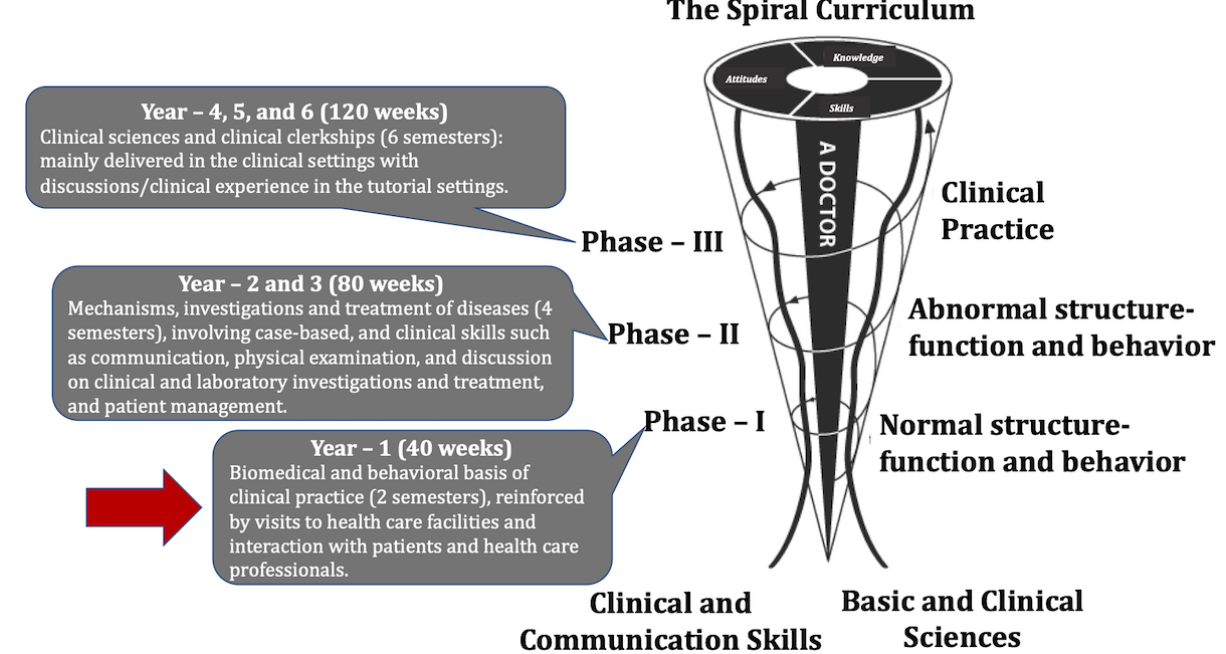
Figure 1. The undergraduate medical curriculum at Mohammed Bin Rashid University of Medicine and Health Sciences (MBRU). The curriculum is divided into three phases and spans over 6 years. Note: Each phase of the undergraduate medical curriculum includes integrated courses and builds on the preceding one, such that the curriculum is a “spiral,” and the students repeat the study of a subject, each time at a higher level of difficulty and in greater depth. The phase in which the teaching framework was implemented is indicated with a red